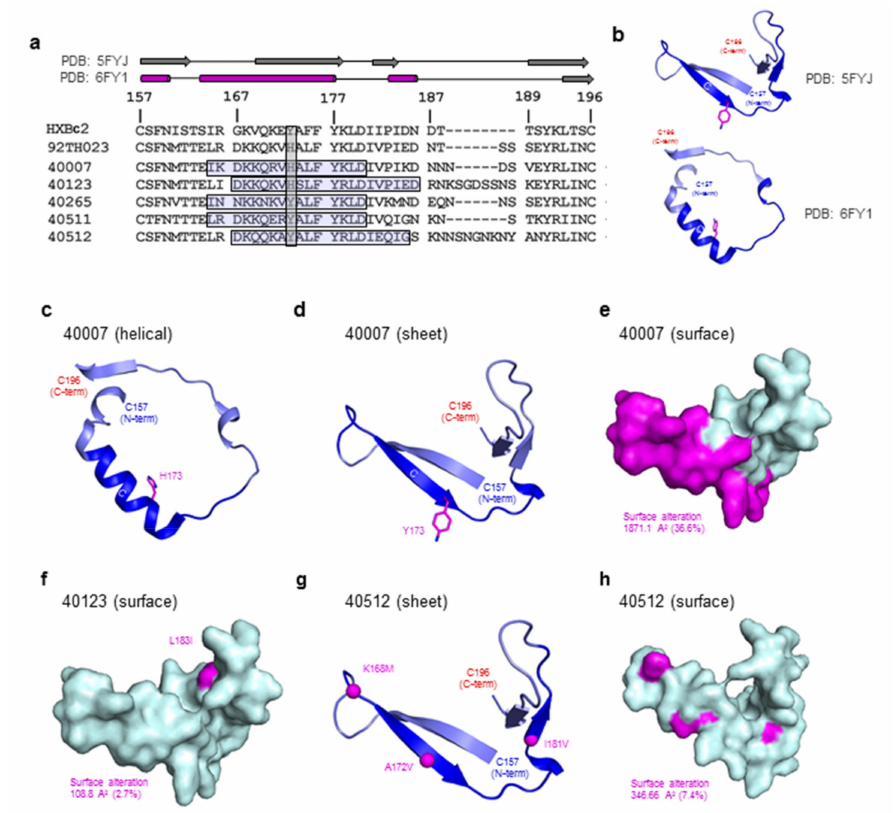
Figure 6. Modeling of the HIV-1 Env V2 region. ( a ) Sequence alignment of RV217 participant T / F sequences with HXBc2, and 92TH023. A schematic of the secondary structure of two representative structures of the V2 region are shown above the sequence. Residue 173 is highlighted in the sequence alignment, and the sequence defined as the V2 segment 2 for each participant is demarcated by a horizontal box. ( b ) Crystal structures of the HIV-1 Env V2 region shown in ribbon representation. ( c , d ) Participant 40007 HIV-1 Env V2 region is modeled with strand C (residues 168–174) in a helical ( c ) or strand (d) conformation. Segment 2 is colored dark blue. ( e , f , h ) surface representation of the T / F V2 region from participants 4007, 40123, and 40512, respectively. In the case of 40007, the V2 region that di ff ers between the helical and strand forms is highlighted in magenta. ( g ) Participant 40512 V2 region is modeled and shown in cartoon representation, with residues within segment 2 that vary over the course of the study indicated in magenta. Surface area changes are indicated in Å 2 . The N- and C-termini of the V2 region are marked in blue and red,